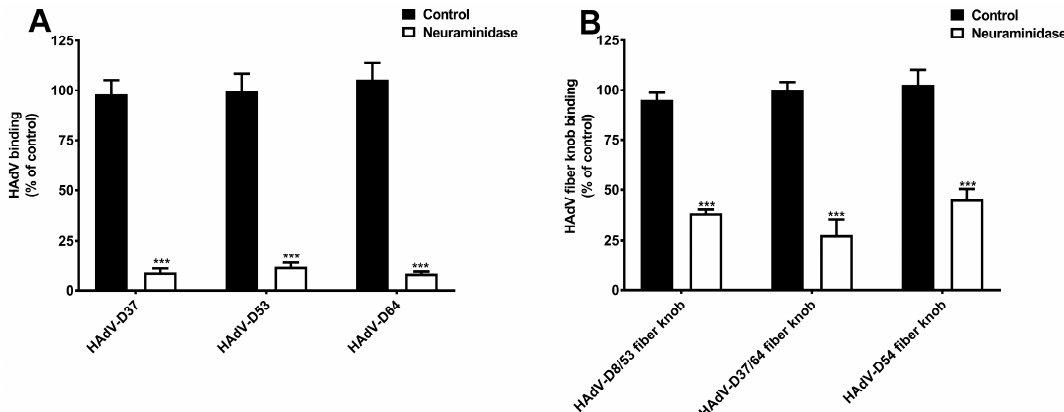
Figure 3. E ff ect of neuraminidase treatment on the binding of epidemic keratoconjunctivitis (EKC)- causing HAdVs to human corneal epithelial (HCE) cells. ( A ) Binding of 35 S-labelled HAdV-D37, -D53, and -D64 to HCE cells pre-treated with and without neuraminidase. ( B ) Binding of HAdV-D8 / 53, -D37 / 64, and -D54 fiber knobs to HCE cells pre-treated with and without neuraminidase. Error bars represent mean ± SEM. *** p < 0.001 relative to control. Table 1. Amino acid sequence identities of the fiber knobs of epidemic keratoconjunctivitis (EKC)- causing HAdVs and their isoelectric points (pI).